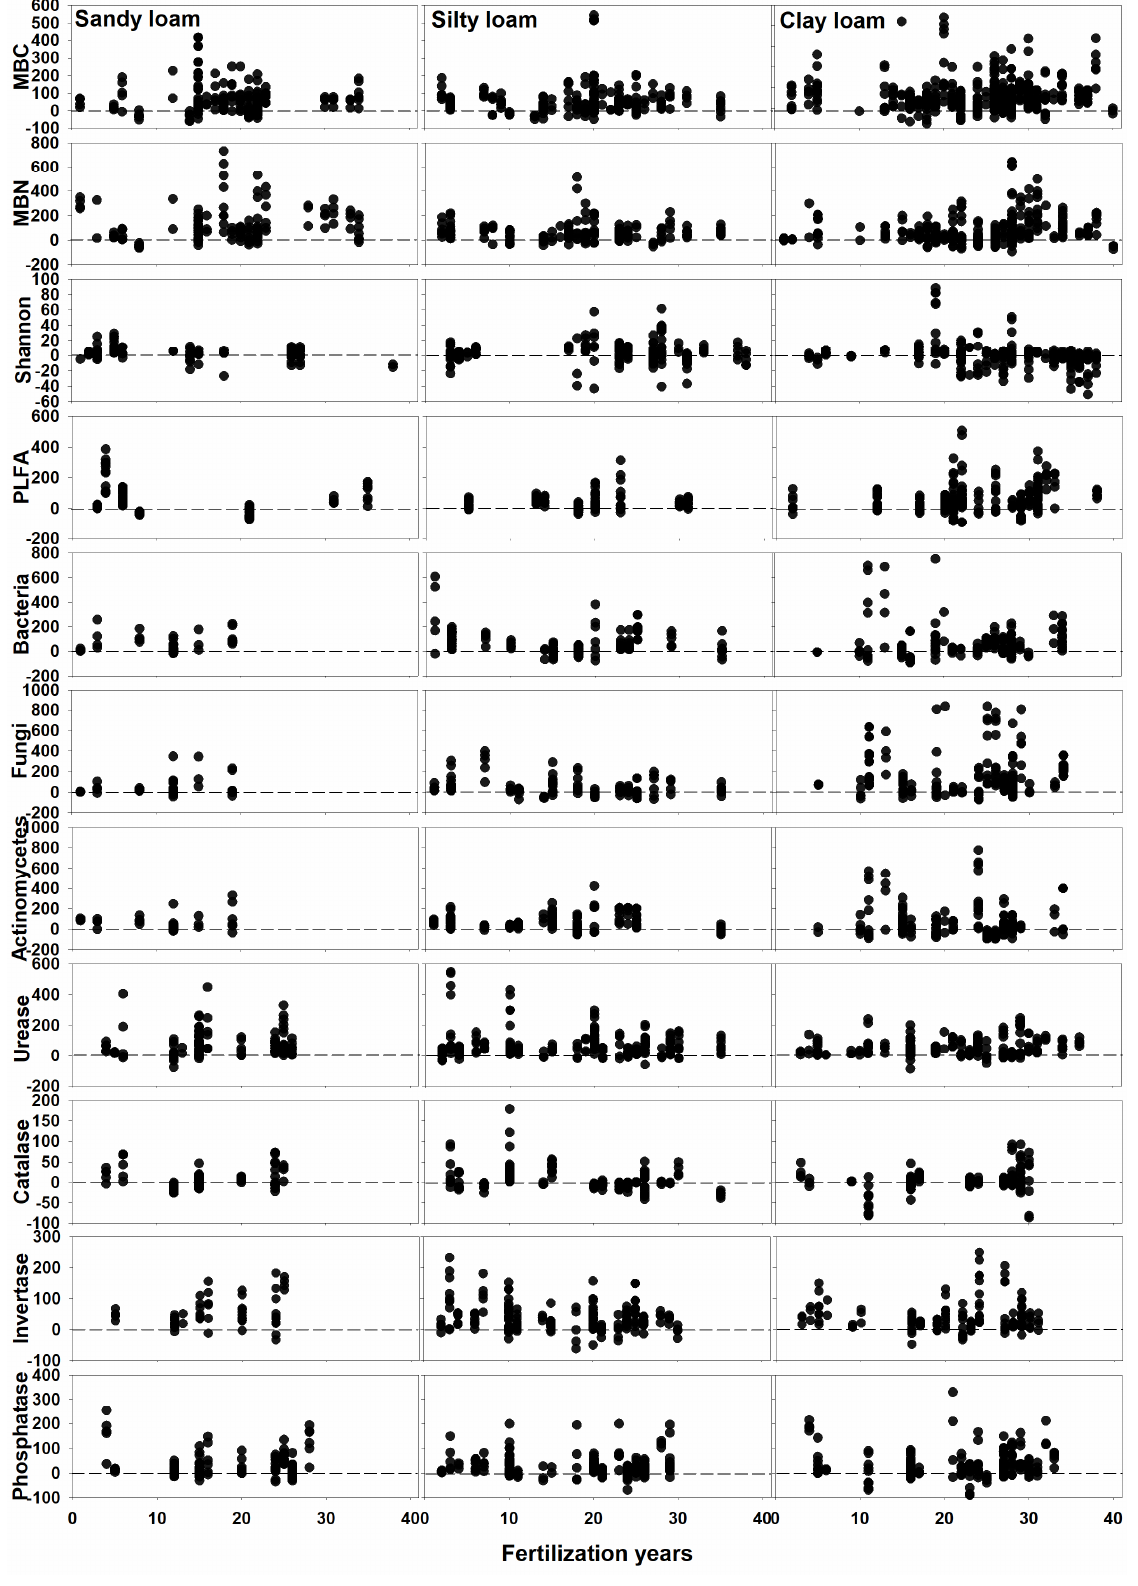
Figure 6. The effects of fertilization on microbial properties (MBC, MBN, Shannon index, PLFA, bacteria, fungi, Actinomycetes , urease, catalase, invertase, and phosphatase) depending on soil texture (sandy loam soils, silty loam soils, clay loam soils) with fertilization